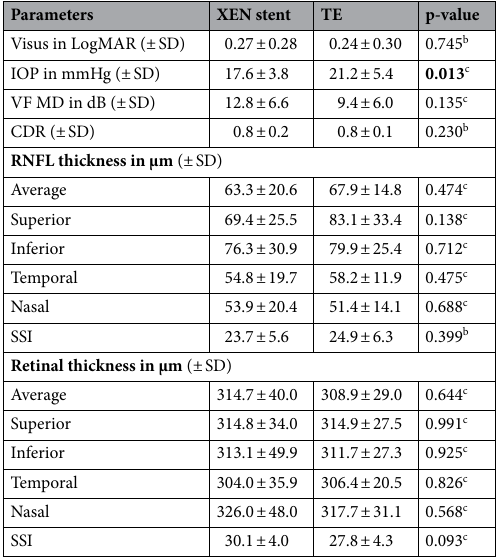
Table 2. Diagnostic measurements. Significant values are in bold. Differences between the groups are shown as mean ± standard deviation. IOP intraocular pressure, VF MD visual field mean deviation, RNFL Retinal nerve fiber layer thickness, CDR cup-to-disc-ratio, pf parafoveal, SSI signal strength index. a Chi-Quadrat test. b Mann-Whitney U test. c t test.